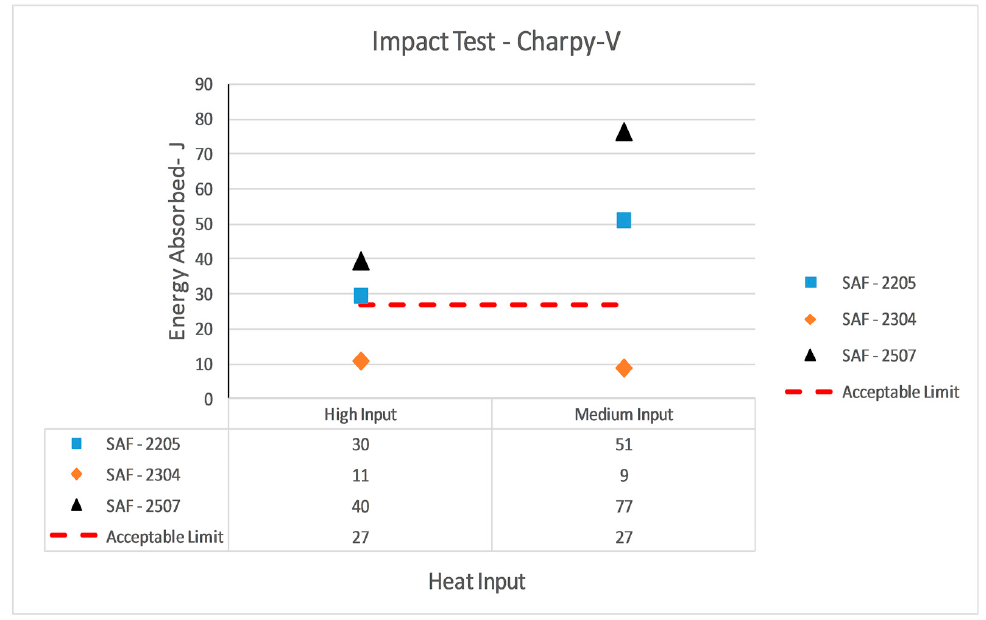
Figure 15. Energy absorbed by the steels. The errors measured in the samples are smaller than the symbol used in Figure 15 and are not shown.